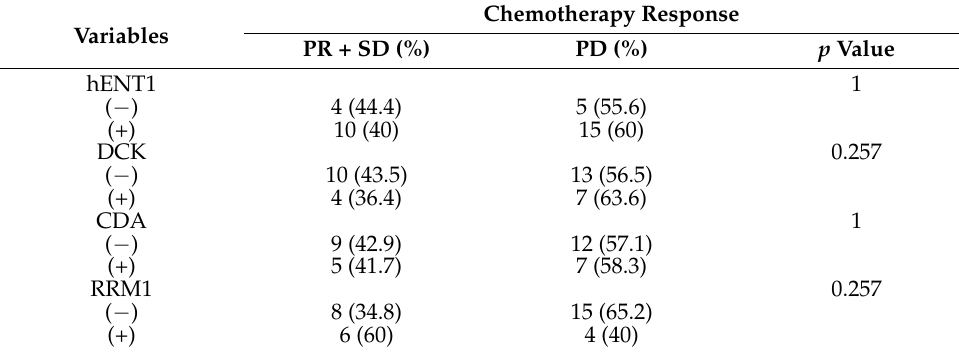
Table 2. Chemotherapy response according to each biomarker expression.